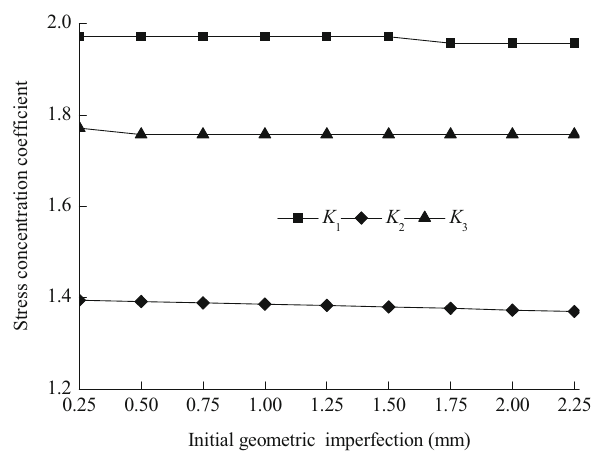
Fig. 14 Relationship between the SCC and initial